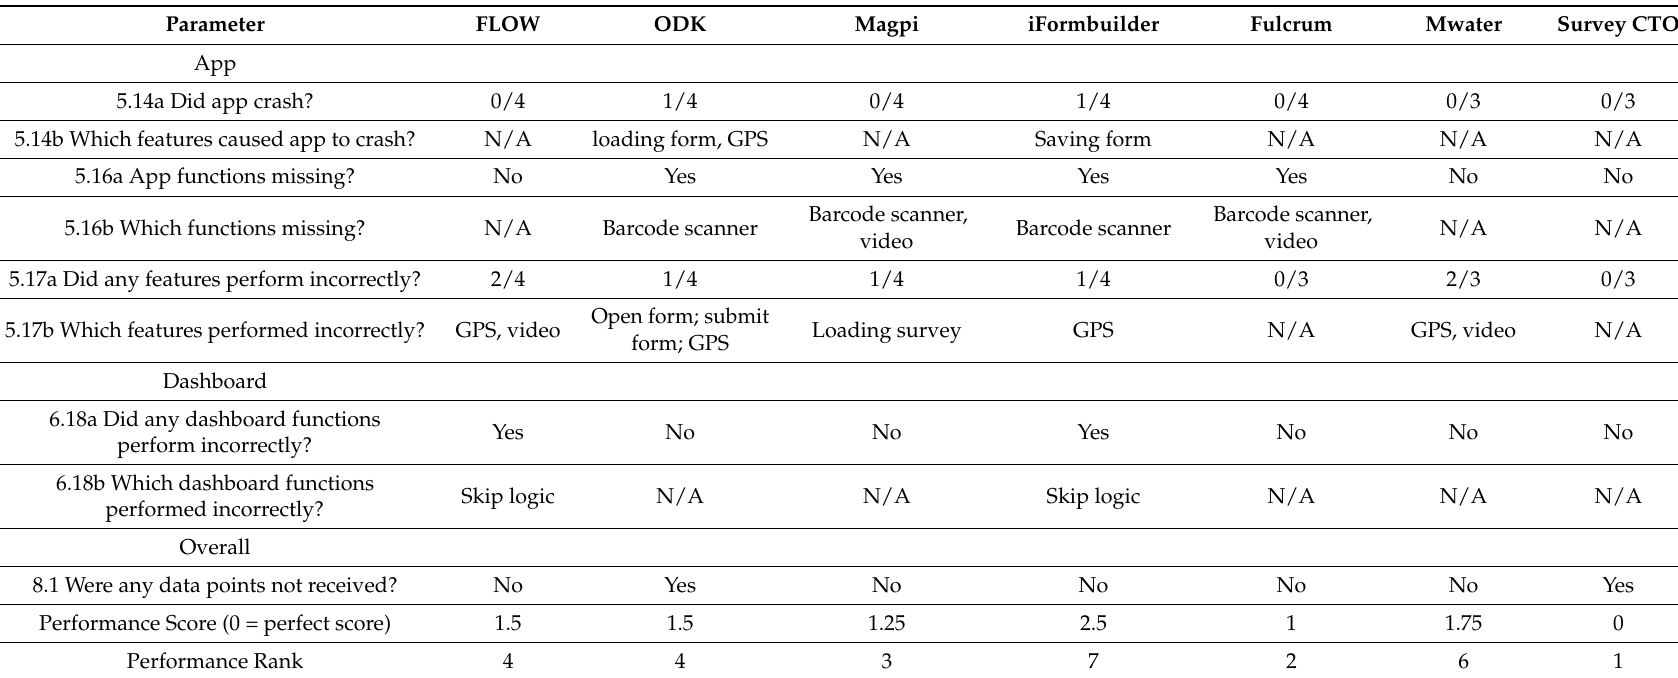
Table 12. Performance and